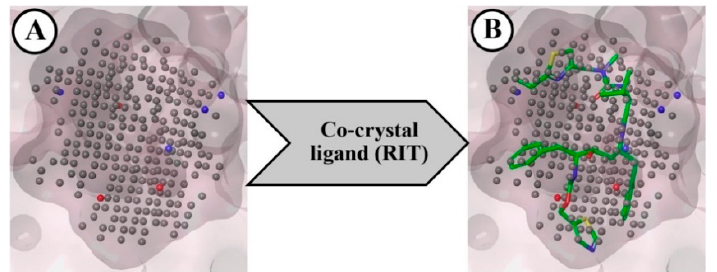
Figure 2. Negative-image based (NIB) model developed from CYP3A5 receptor cavity ( A ), and RIT model mapped with NIB model ( B ).